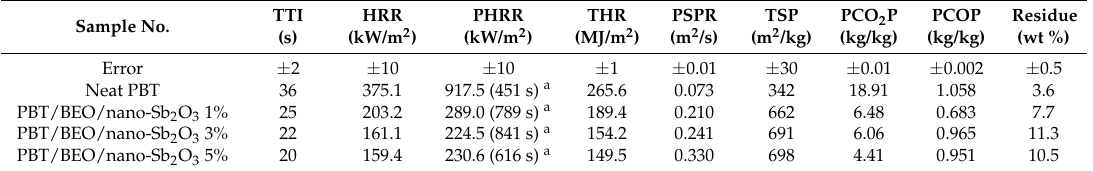
Figure 4. ( a ) Heat release rate (HRR); ( b ) total heat release rate (THR); ( c ) smoke production rate (SPR); ( d ) total smoke production (TSP); ( e ) CO 2 production; ( f ) CO production as a function of the burning time for the neat PBT and its composites in the cone calorimeter tests at 50 kW/m 2 . Table 5. Cone calorimeter data for the neat PBT and its composites at a heat flux of 50 kW/m 2 . Sample No.